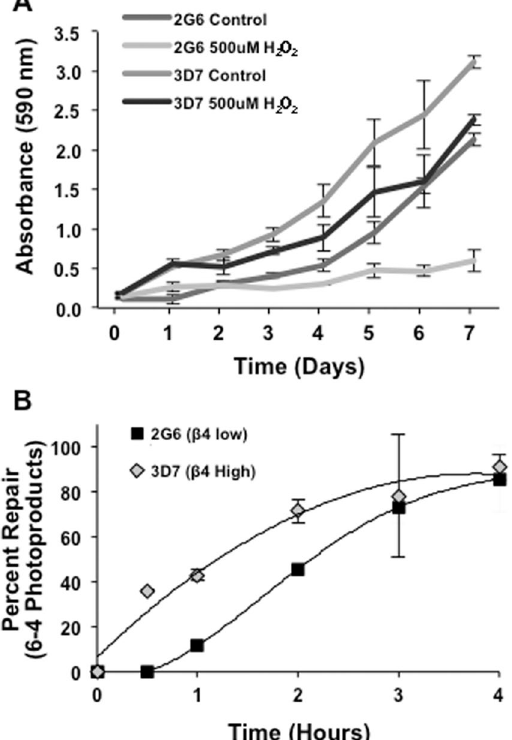
Figure 7. Integrin α 6 β 4 promotes DNA repair and cell survival in response to DNA damage. ( A ) Cells were treated with 500 μ M H 2 O 2 in fresh medium daily for 7 days. Each day cell proliferation was measured by MTT colorimetric assay. ( B ) Cells were exposed to 30 J/m 2 UV light and DNA isolated at indicated time points. Slot blot assay was performed using antibody for 6-4 photoproducts and percent repair compared to damage achieved immediately after exposure (0